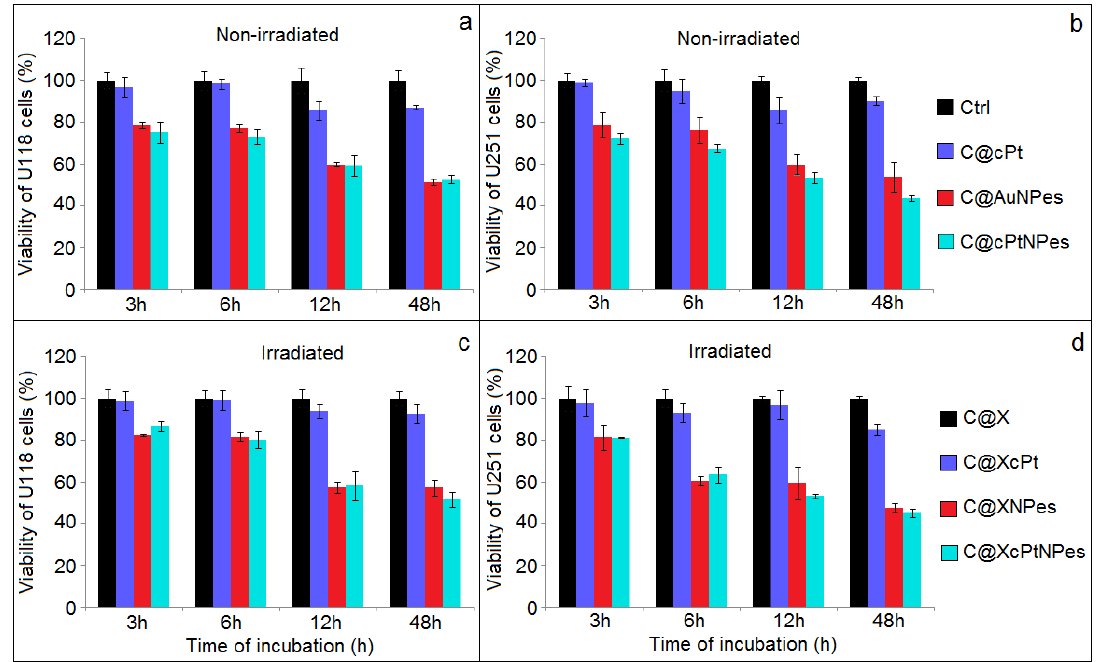
Figure 3. Comparison of the viability of U118 MG and U251 MG cell lines determined via the MTT assays in not-irradiated ( a , b ) and irradiated ( c , d ) cells by 2 Gy of X-rays after different time of incubation (3, 6, 24 and 48 h) with cisplatin, Au NPes and cPt@Au NPes and compared with controls. Irradiating with 2 Gy X-ray dose resulted in a gradual decrease of cell viability for both cell lines cultured with cPt, Au NPes or cPt@Au NPes as a function of incubation time after irradiation (Figure 3c,d). cPt@Au NPes were more efficient in inducing the U118 MG cell killing compared to Au NPes,